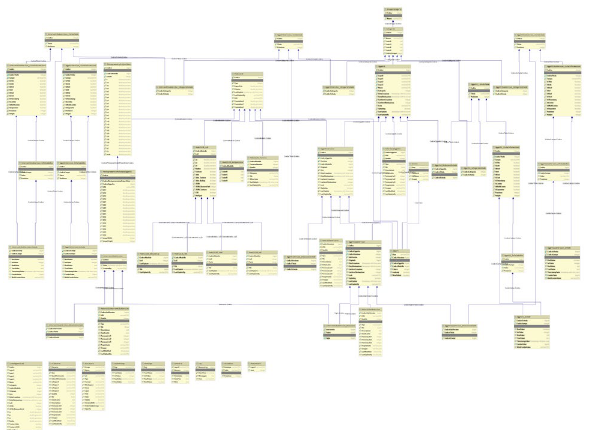
Figure 2 – The database structure of